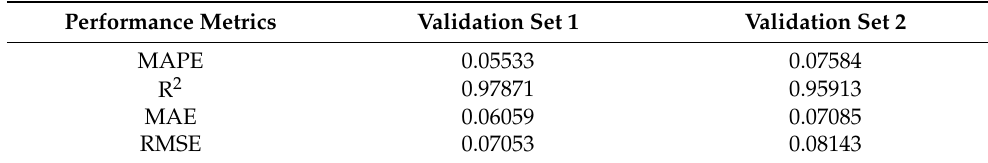
Table 5. Results of model regression accuracy test.